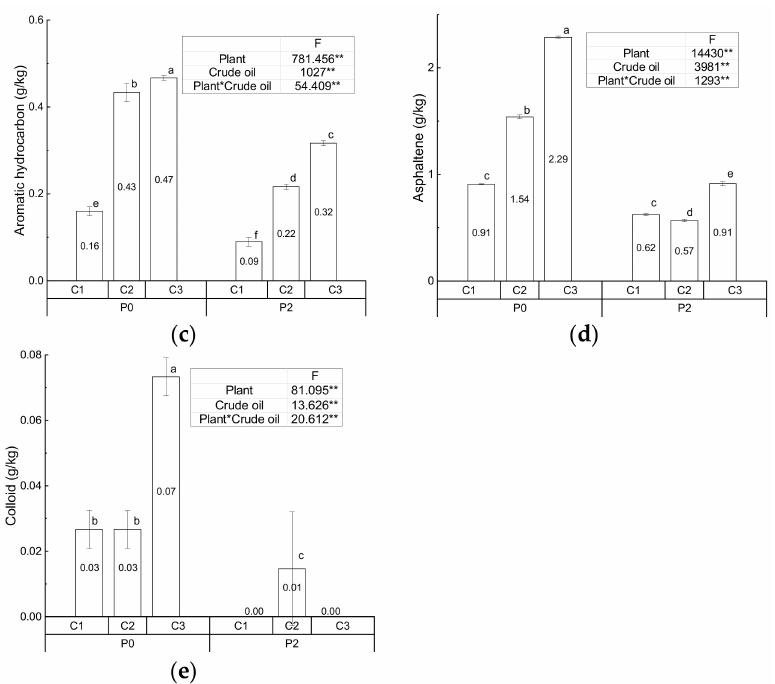
Figure 2. The crude oil ( a ), saturated hydrocarbon ( b ), aromatic hydrocarbon ( c ), asphaltene ( d ) and colloid ( e ) in controls and treatments. (** indicates the significant di ff erence at the 0.01 level, and average values are in the center of column (calculated from three replicates), meanwhile the error bar of the column is the value of standard deviation. Columns noted by the same and di ff erent small letter means insignificant and significant di ff erence at the 0.05 level, respectively. Colloid data in the low and high contamination with S. salsa are below the detection